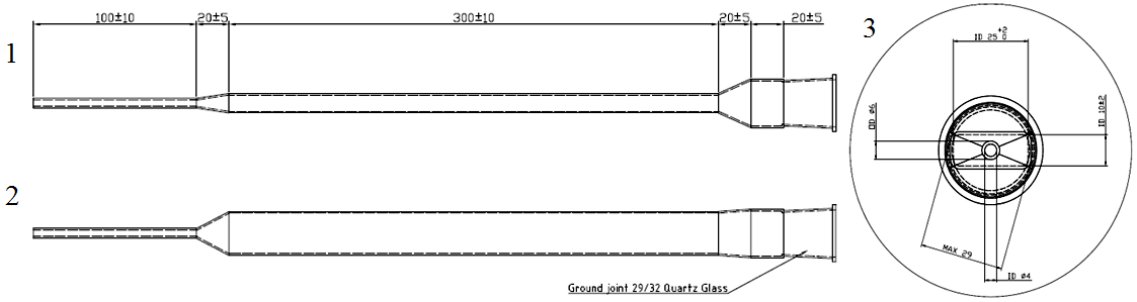
Figure 2. Computer-aided design (CAD) drawing of the quartz distillation tube designed to hold a target of 24 mm in diameter. The actual length of the distillation tube can be changed to fit the length of the tube furnace. 1 : Side view 2 : Top view 3 : End view. (Unit: mm).